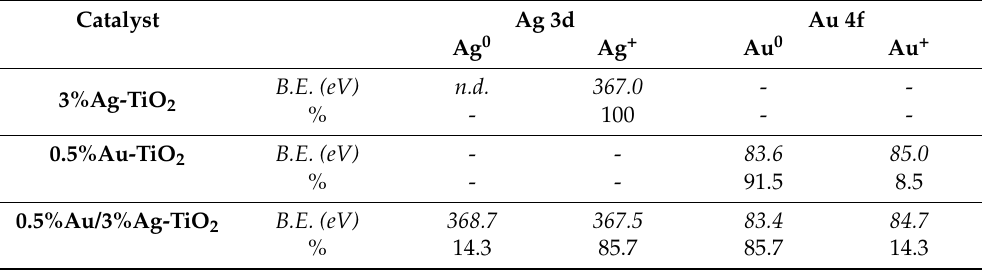
Table 3. Fitting results of high-resolution XPS spectra of Ag 3d and Au 4f regions for 3%Ag-TiO 2